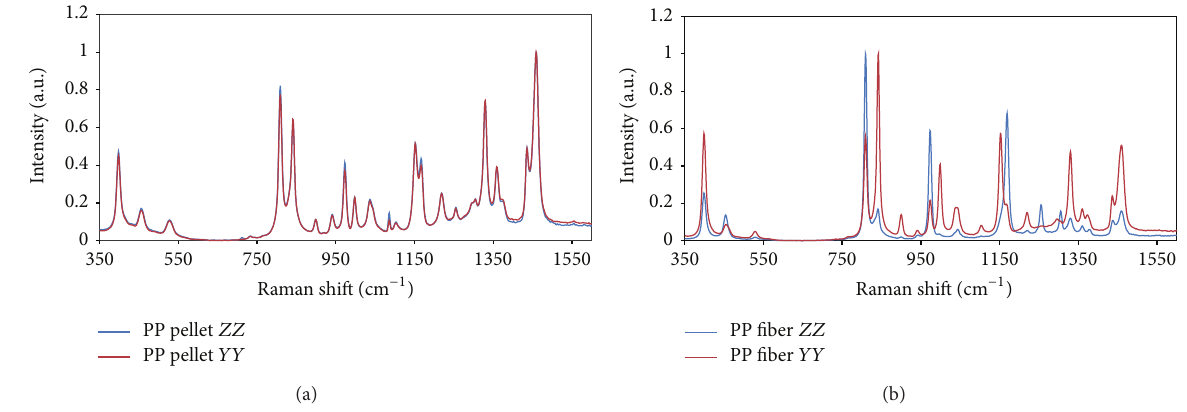
Figure 2: (a) 𝑍𝑍 and 𝑌𝑌 spectra of a PP pellet; (b) 𝑍𝑍 and 𝑌𝑌 spectra of a PP fiber.